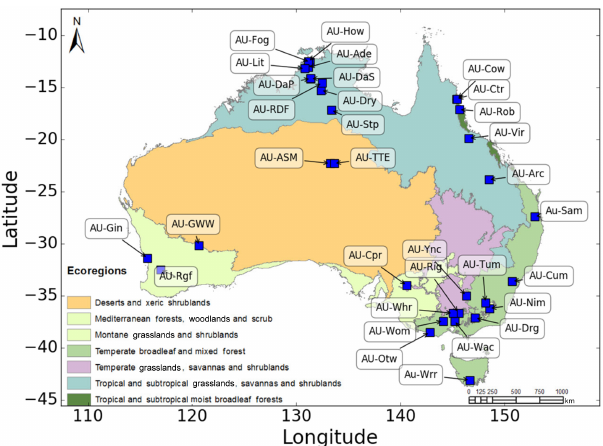
Figure 1. Major Australian biomes defined using the Interim Bio- geographic Regionalisation for Australia v. 7 (IBRA) (Environ- ment, 2012). Flux sites from Table 1 are shown illustrating the wide geographical and biome space, but each biome is not equally repre- sented. Only a small fraction of the OzFlux sites (8%) are located in the arid/semi-arid biomes that comprise 74% of the